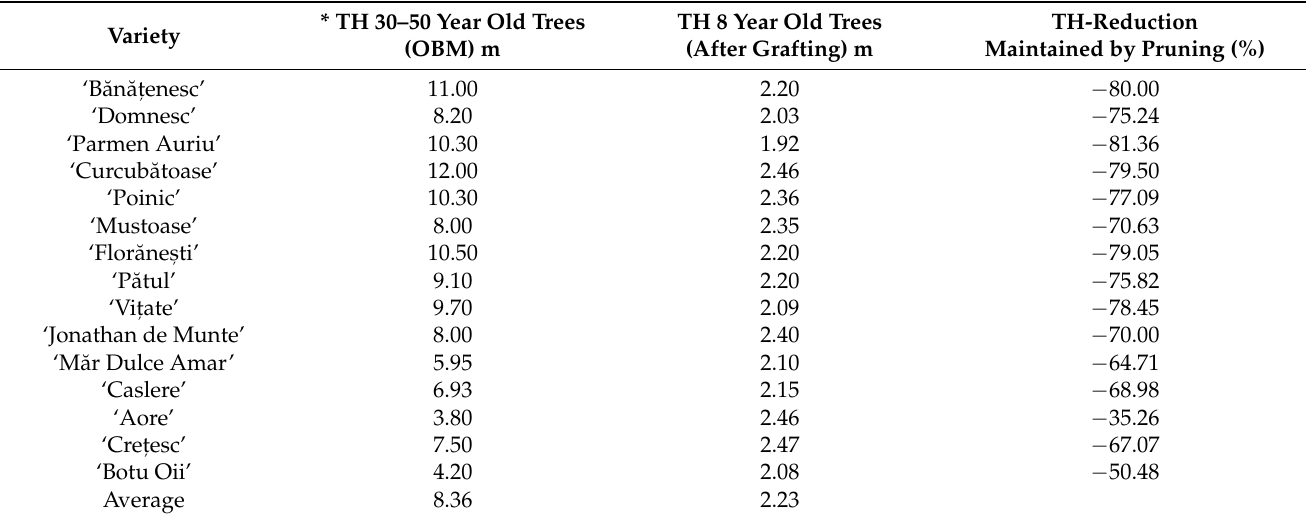
Table 2. Differences between tree height before and after grafting.